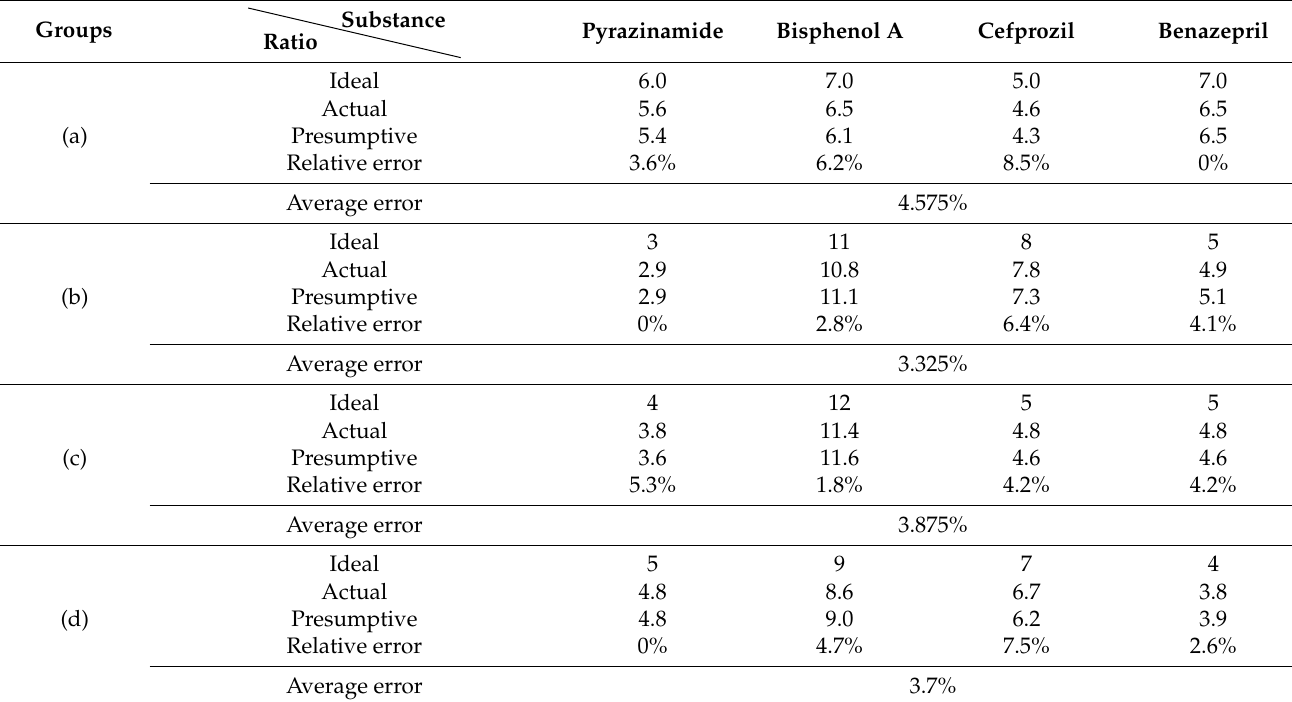
Figure 6. The THz spectra of the mixtures under different mix—ratio and the comparisons between the predicted and the actual spectra. The weight ratios of pyrazinamide, bisphenol A, cefprozil, and benazepril in mixture: ( a , e ) 6:7:5:7, ( b , f ) 3:11:8:5, ( c , g ) 4:12:5:5, and ( d , h ), 5:9:7:4 ( e – h ), respectively. The comparisons of the theoretically predicted spectra based on algorithm (red circle line) and the actual tested spectra (black square line). Table 1. The quantitative analysis of the four substances in mixtures.